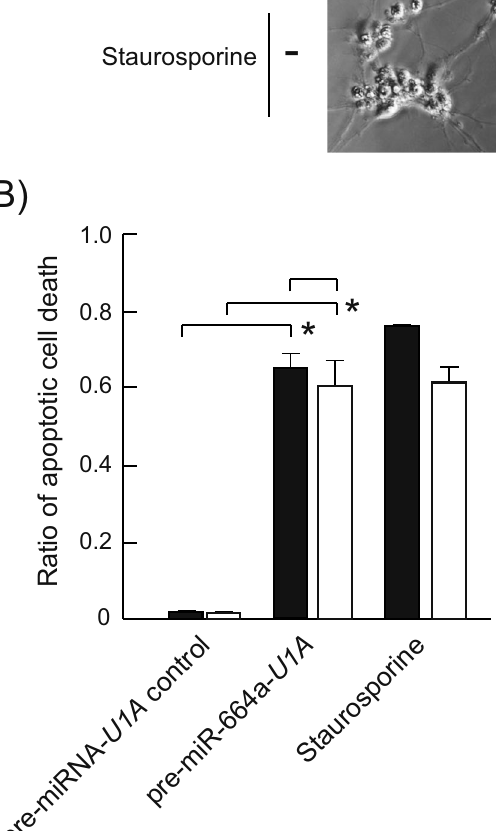
Figure 4. pre-miR-664a- U1A delivered by photoinduced cytosolic dispersion of RNA (PCDR) induces apoptosis. ( A ) pre-miRNA- U1A control or pre-miR-664a- U1A were delivered into SH-SY5Y and HeLa cells using PCDR. Then, the cells were photo-irradiated. Apoptotic cells were detected using NucView 488 caspase assay kit. Staurosporine was used as a positive control. PC: Phase contrast images. Scale bars indicate 100 µm. ( B ) Apoptosis efficiency of SH-SY5Y (black bar) and HeLa cells (white bar). Data represent the means ± SEM of five independent experiments. *P < 0.01; P-values were calculated using two-way ANOVA and Tukey’s multiple comparisons